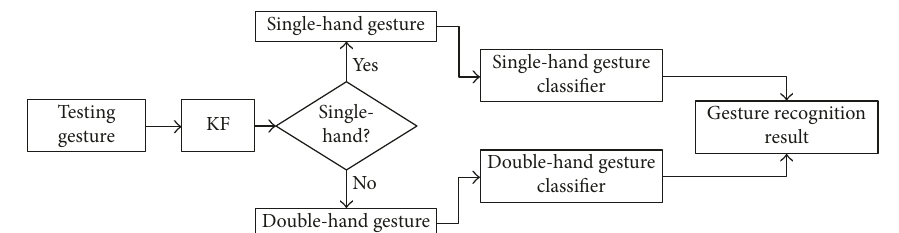
Figure 28: The testing pipeline of gesture